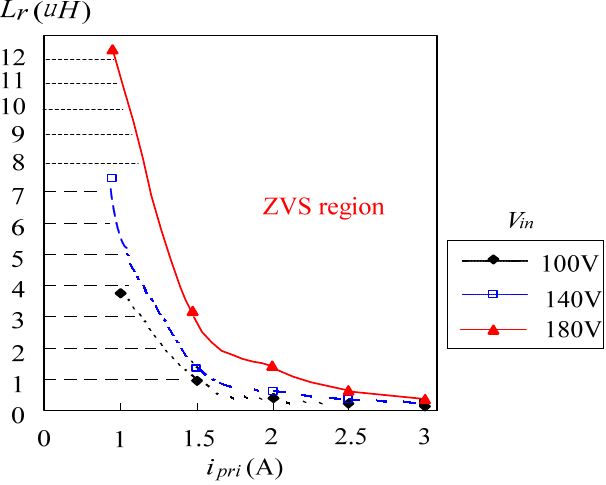
Figure 15. Plots of the ZVS region relating to resonant inductor L ipriunder different input